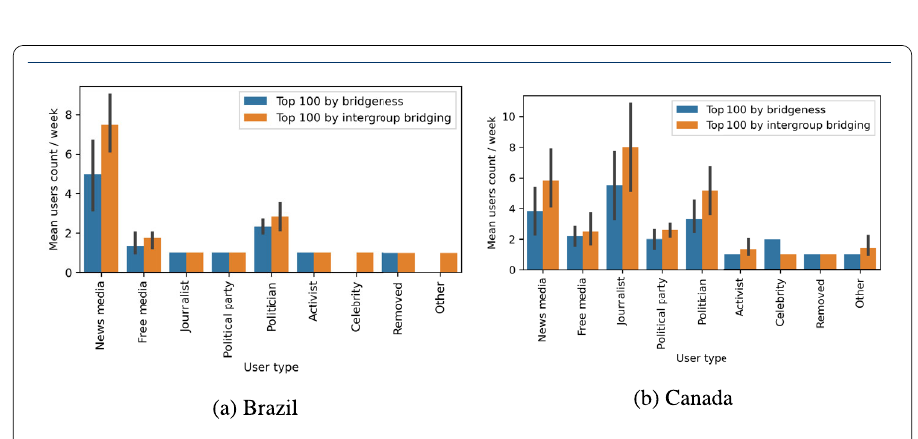
Figure 8 Mean number of accounts per week according to its type. This analysis considers only verified accounts among the top 100 verified ones in all weeks by each centrality metric